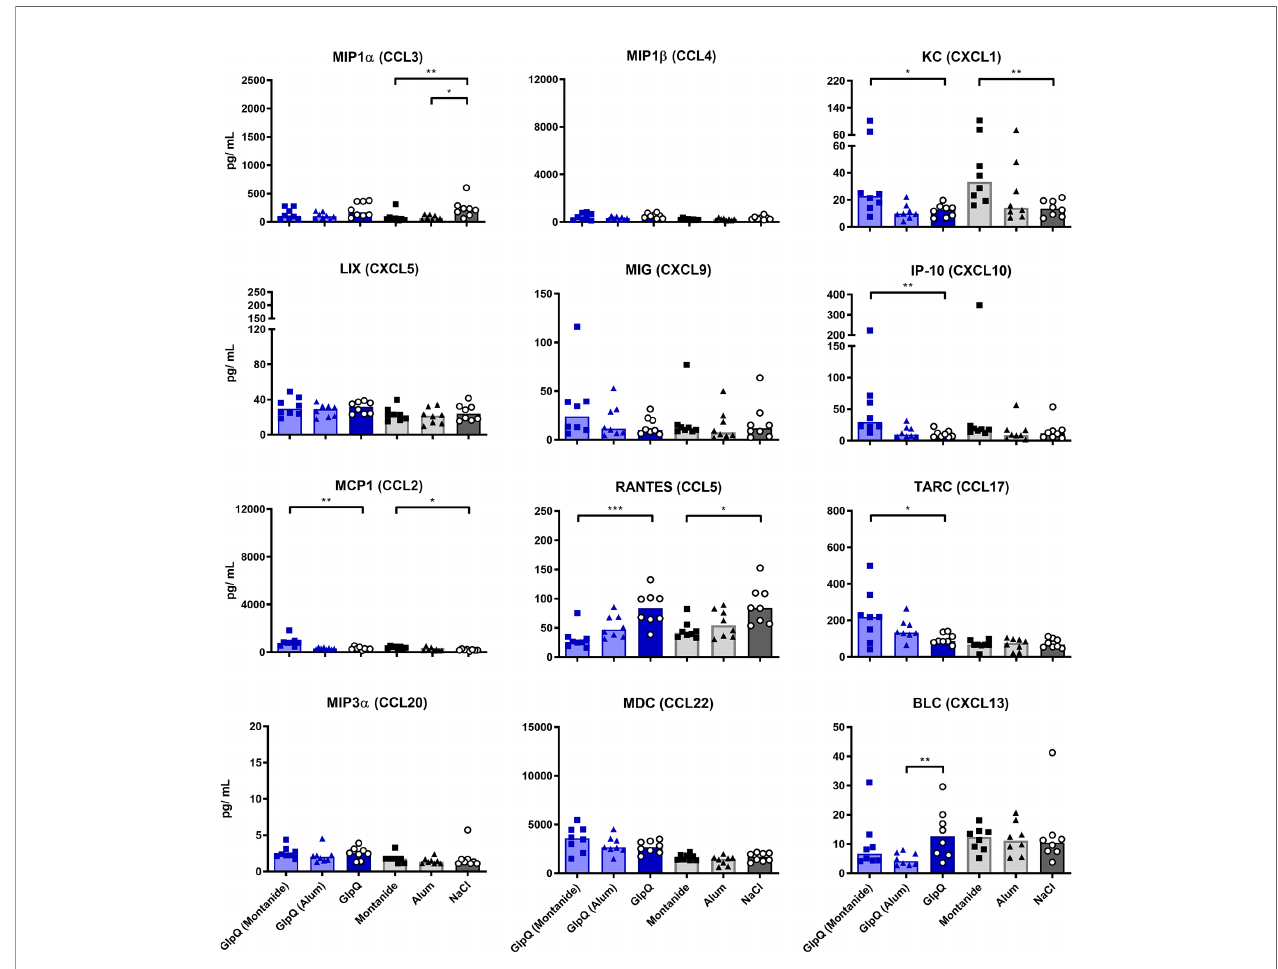
FIGURE 7 | GlpQ restimulation provoked little chemokine production. Isolated splenocytes were restimulated with GlpQ for 4 days, afterward the supernatant was harvested and the concentration of produced chemokines was measured via the LEGENDplex ™ Mouse Proin fl ammatory Chemokine Panel (13-plex). Data are presented as median. n = 8 animals per group. *p < 0.05; **p < 0.01; ***p < 0.001. Group comparisons that are de fi ned in the “ Statistical analysis ” section but not shown here are not signi fi